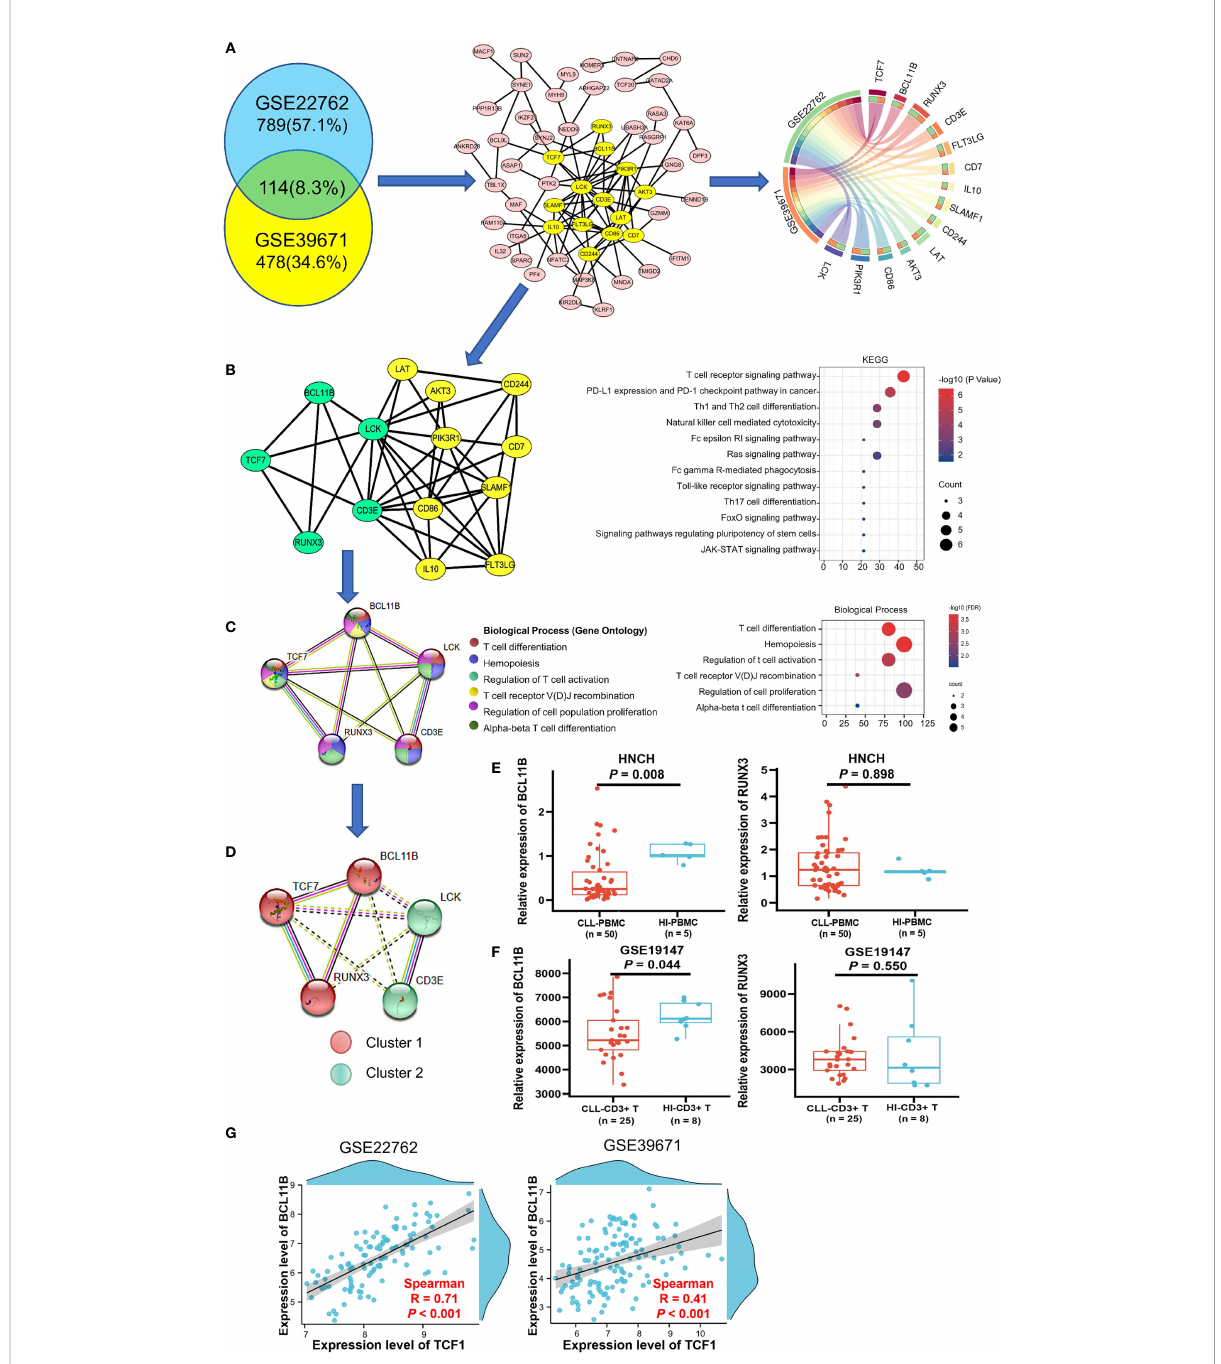
FIGURE 3 Biological process and KEGG pathway analysis of TCF7 co-expressing genes and partner gene screening in patients with CLL. (A) The 114 common co-expressing genes (R > 0.3 P < 0.05) in the GSE22762 and GSE39671 datasets were fi ltered by the Venny online tool (left panel). Then, the STRING online tool was used to create the PPI network, MCODE analysis (middle panel) identi fi ed the 14 hub genes (highlighted in yellow), and the correlations of the 14 hub genes in the GSE2276 and GSE39671 datasets were plotted by the Circos web tool (right panel). (B) The PPI network of the 14 hub genes and their KEGG pathway annotation. (C) The PPI network and biological processes of 5 hub genes was directly related to TCF7 . (D) MCL clustering analysis demonstrated a close relationship among TCF7 , BCL11B , and RUNX3 in CLL patients in the GSE22762 and GSE39671 datasets. The expression of BCL11B and RUNX3 was measured in CLL patients from the HNCH (E) and GSE19147 (F) dataset, respectively. (G) The correlation between TCF7 and BCL11B in the GSE39671 and GSE22762 datasets, respectively. R, Spearman correlation coef fi cient. Error bars indicate